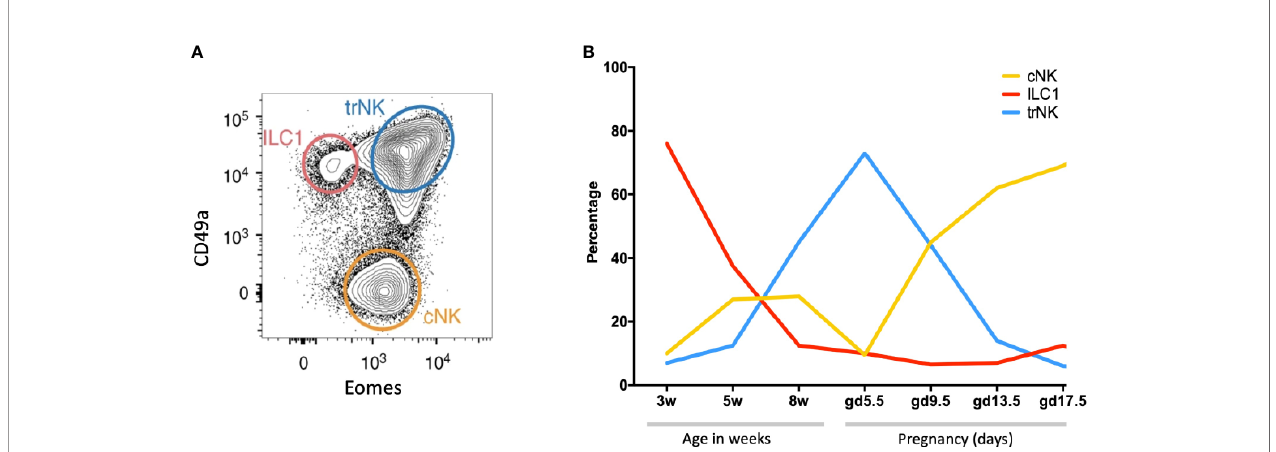
FIGURE 7 | Dynamic changes of NK and ILC1s in the mouse uterus before and after pregnancy (A) Gating strategy to identify uterine NK and ILC1 subsets. Cells isolated from whole uterus were analysed together. Representative 2D FACS plot is from gestational day 9.5 (gd 9.5) and gated on Live CD45+CD3 − CD19 − CD11blow/- NK1.1+NKp46+ cells. ILC1s (red line) are CD49a+ Eomes − , tissue resident NK (trNK, blue) are CD49a+Eomes+, conventional NK (cNK, gold) are CD49a − Eomes+. (B) Proportions of indicated uterine subsets at different stages of the reproductive cycle as a percentage of the total Live CD45+CD3 − CD19 − CD11blow/- NK1.1+NKp46+ cells. w = weeks of age, gd = gestational day [Figure adapted from Filipovic et al.